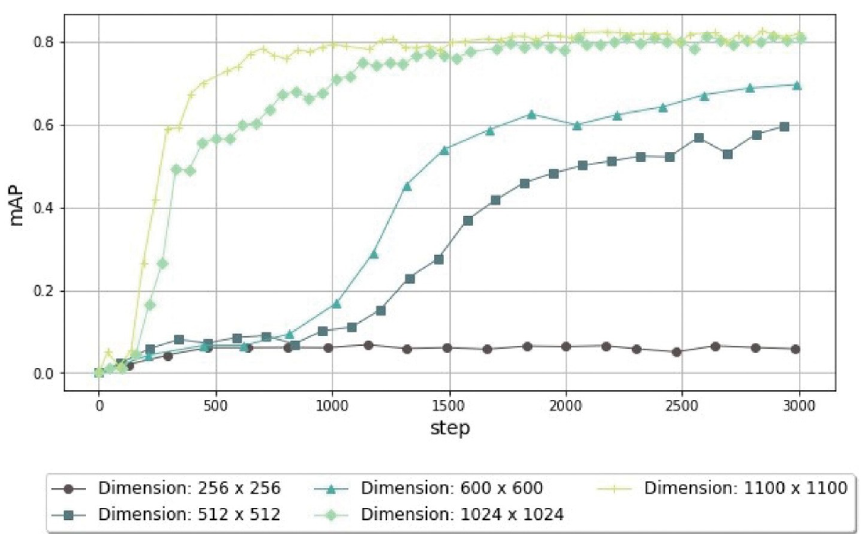
Fig 6. Performance comparison using the mAP of the object-detection models trained using different image sizes (from 256 × 256 pixels to 1100 × 1100 pixels) for 3,000 steps. When dealing with very small cells with a small number of pixels, it is important to increase the resolution of the image to improve the richness of features. In this way, the detector can correctly identify and classify the cells.